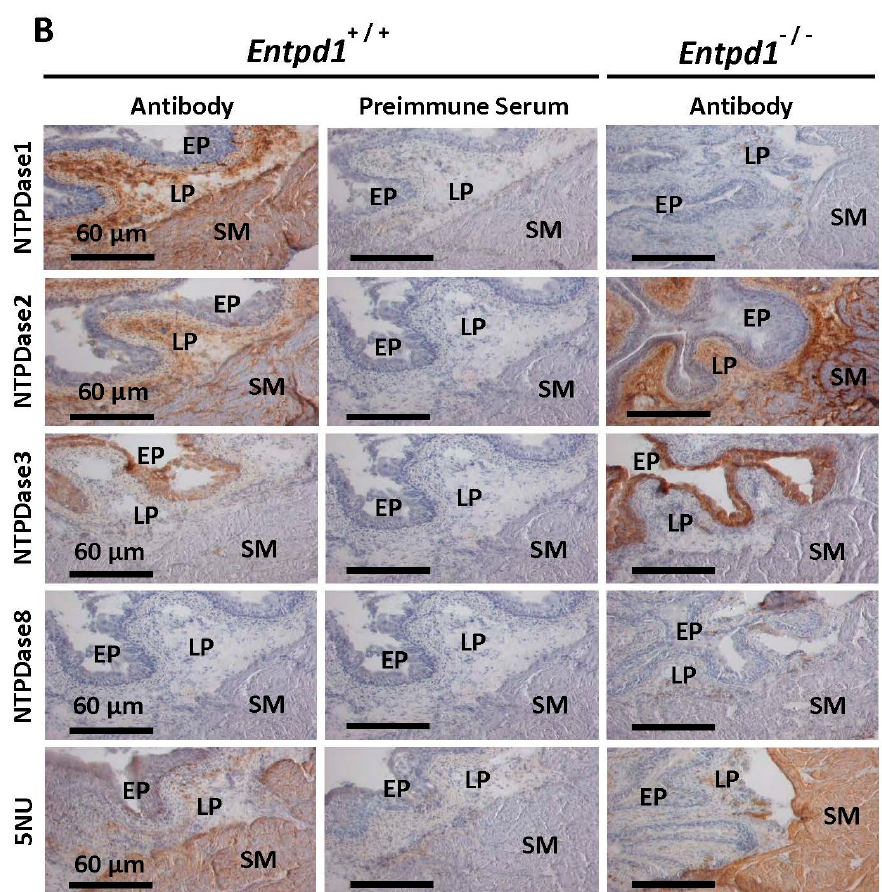
Figure 1. Immunolocalization of ectonucleotidases in male ( A ) and female ( B ) mouse bladder. SM: smooth muscle; LP: lamina propria. EP: epithelium. bar = 60 µm. Entpd1 +/+ : wild type mice. Entpd1 − / − : NTPDase1 deficient mice. 5NU: ecto-5 ′ - nucleotidase. Experiments were done on 3 mice of each group.